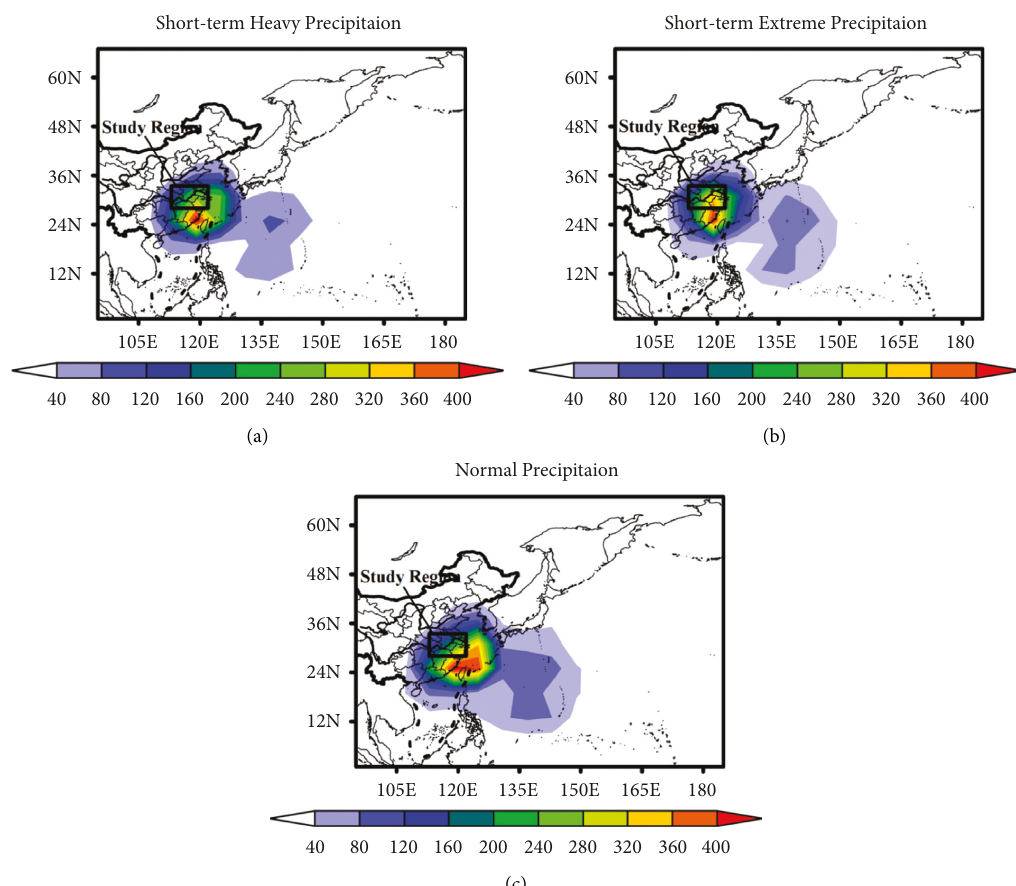
Figure 7: Spatial distribution of the frequency of typhoon tracks causing different precipitation